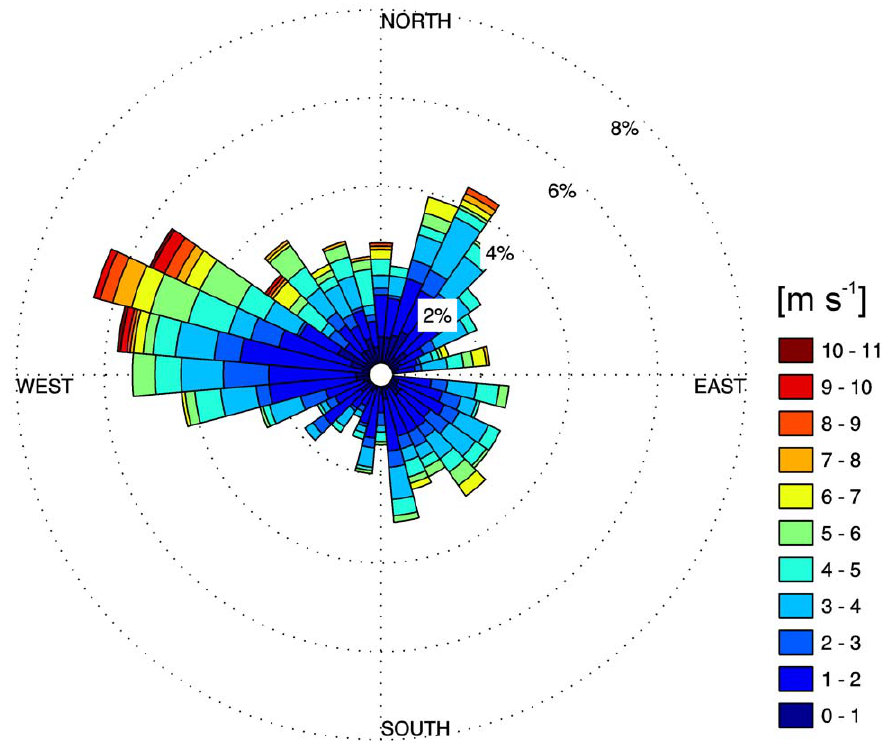
Figure 2. Wind rose for the Barrie Airport Weather Station for August and September 2011, i.e. DOY 216–257. Direction indicated is that from which wind is blowing. Concentric rings (2, 4, 6 and 8) give percentage of time wind is from that particular direction; colors within a wedge represent the relative proportion of time the winds from that direction are of a certain magnitude.